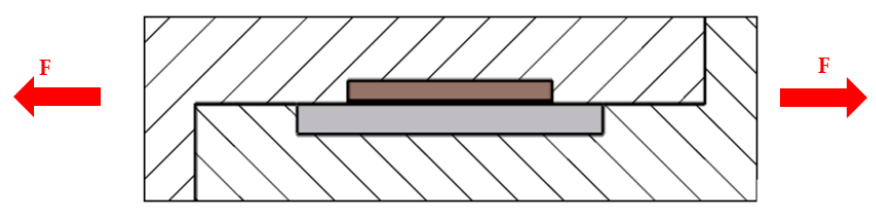
Figure 4. Schematic representation of shear strength measurement with a special jig.